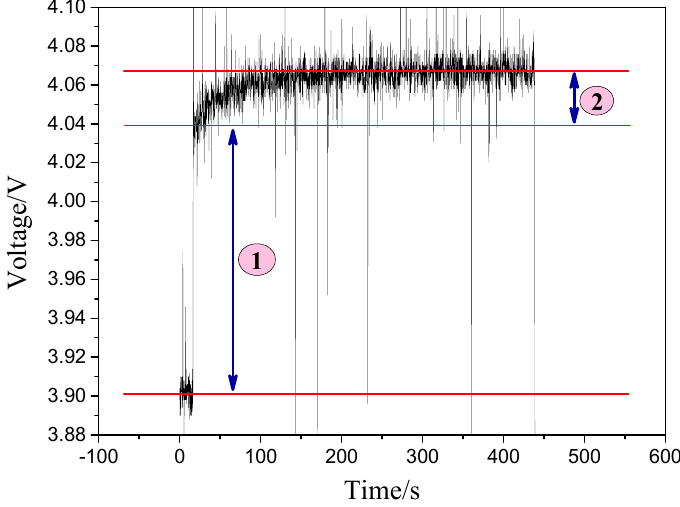
Figure 2. The terminal voltage response after the completing a discharge cycle.